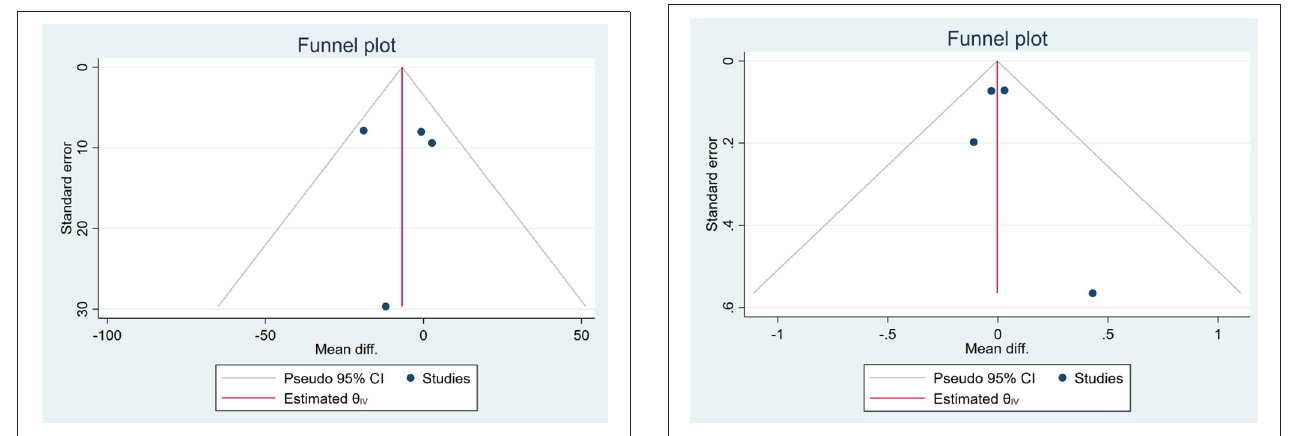
FIGURE 27 | Funnel plots of the effect of TC.